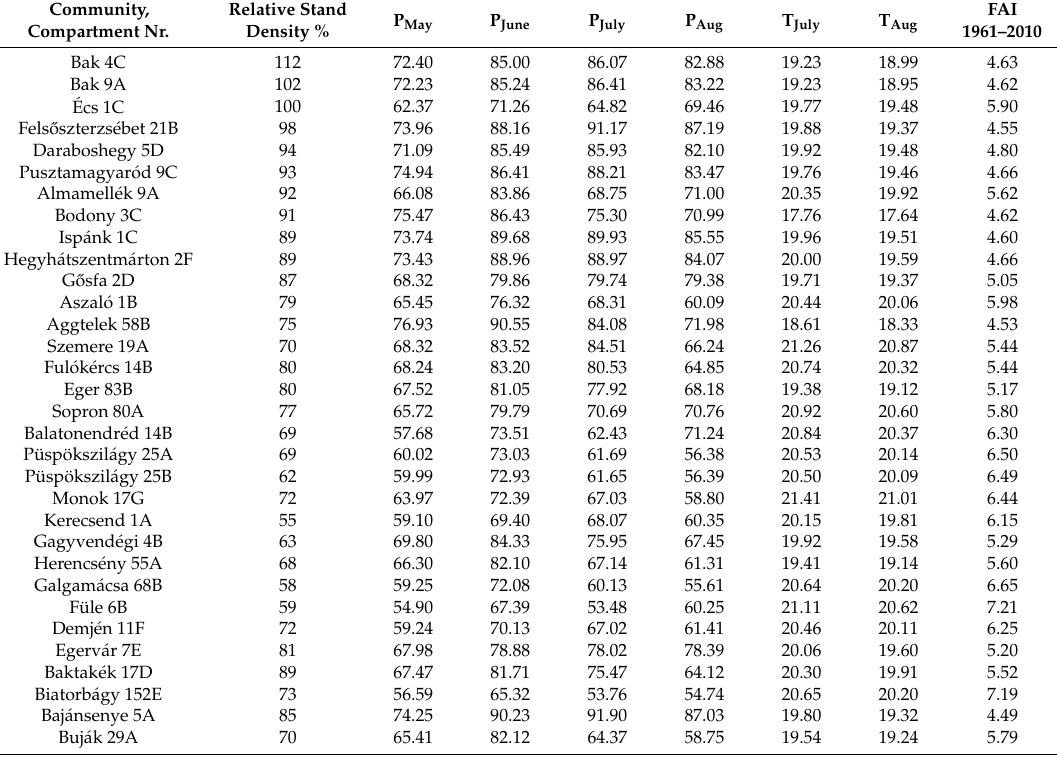
Table A1. Relative stand density of 32 zonal sessile oak stands and FAI values of their locations. FAI values were calculated from monthly means of the period 1961–2010. Community, Compartment